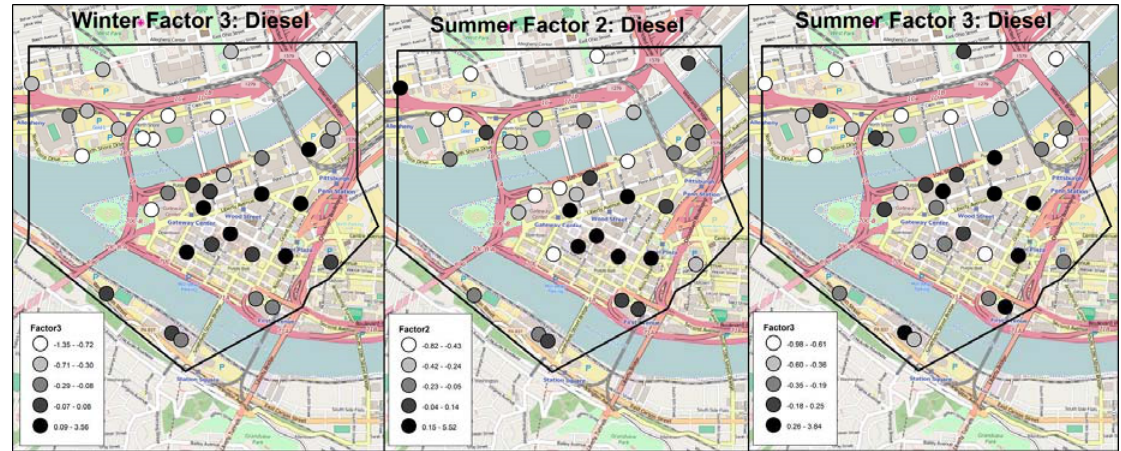
Figure 3. Spatial distribution of factor scores across monitoring locations for diesel-interpretsed factors (winter factor 3, summer factors 2 and 3).